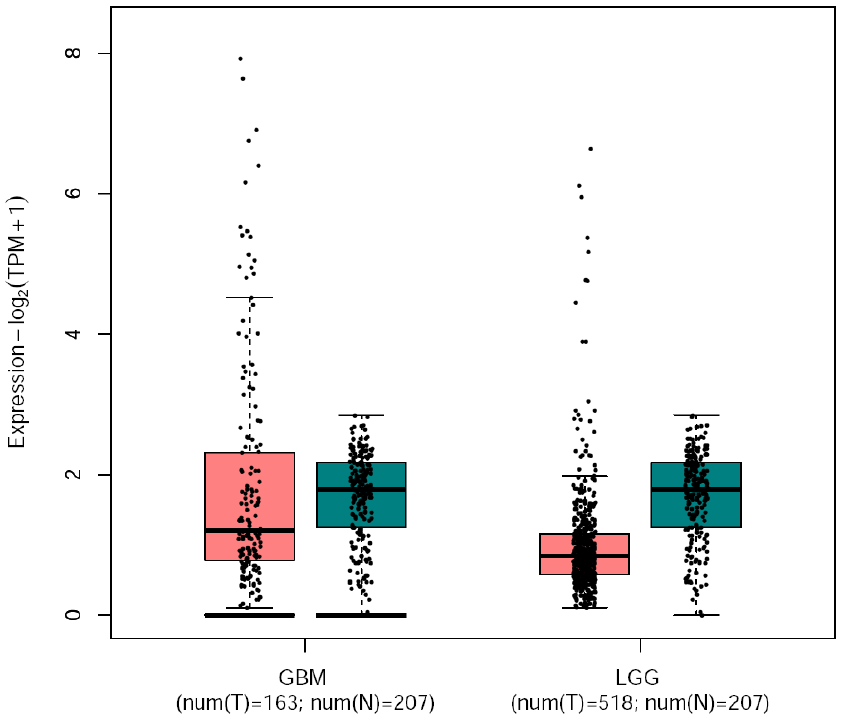
Figure 1: iNOS/NOS2 mRNA relative expression scatter plot of tumor tissues and corresponding normal tissues of glioma patients.